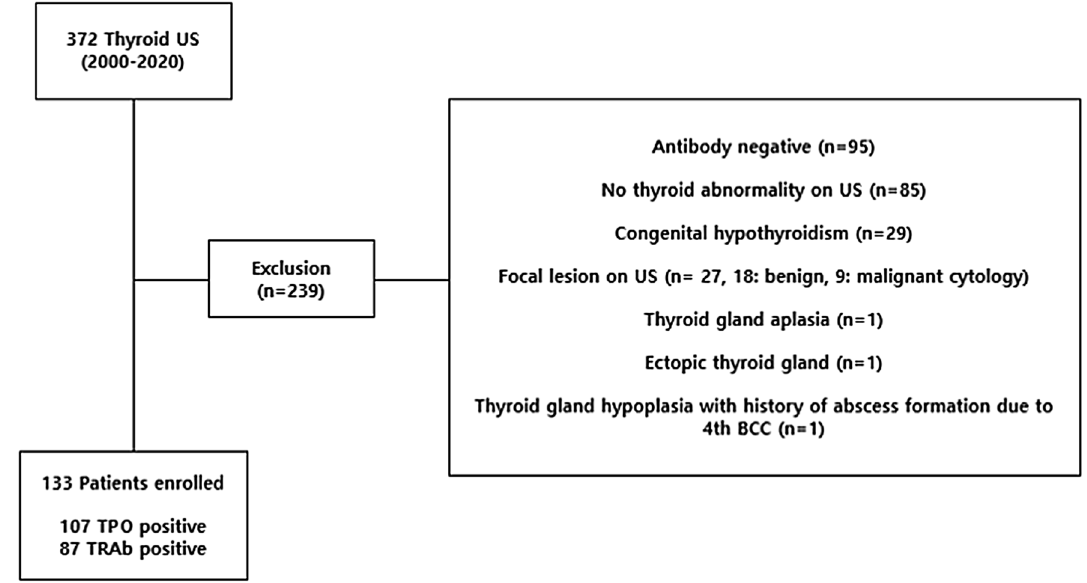
Figure 5. Flowchart of overall study population enrollment.